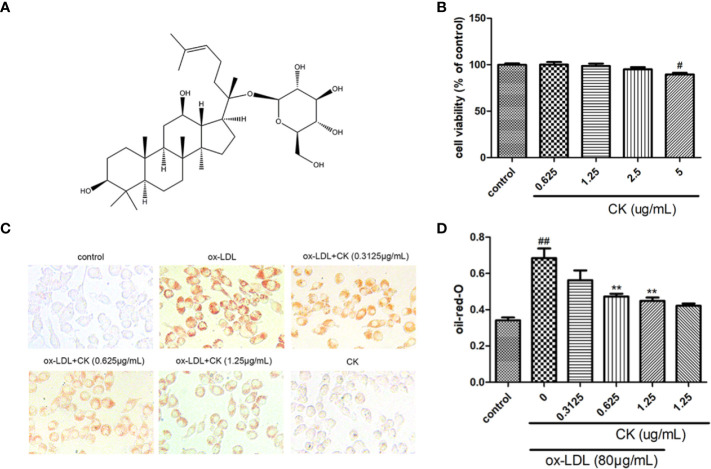
CK inhibited ox-LDL-induced RAW264.7 cells lipid accumulation. RAW264.7 cells were treated with CK at various concentrations for 12 h with or without 80 μg/ml ox-LDL for additional 24 h. (A) The chemical formula for CK. (B) Cell viability was assayed by the MTT assay. (C) Representative images of Oil Red O staining. (D) Oil red O positive area was measured by Image J software. All data are shown as mean ± SD from three independent experiments with each performed in triplicate. #P < 0.05, ##P < 0.01 vs. control group; **P < 0.01 vs. ox-LDL-treated group. CK, compound K; ox-LDL, oxidized low-density lipoprotein; MTT, (4, 5-dimethylthiazol-2yl-)-2,5-diphenyl tetrazolium bromide.